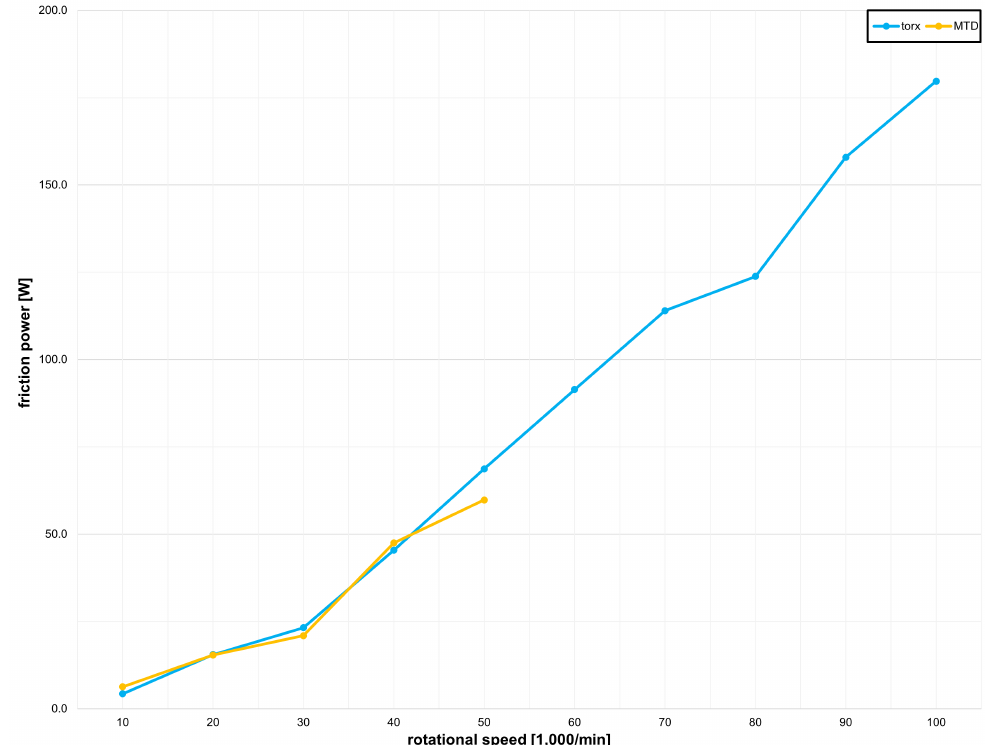
Figure 9. FTB–Comparison of torx and magnetic coupling solutions: friction power over rotational